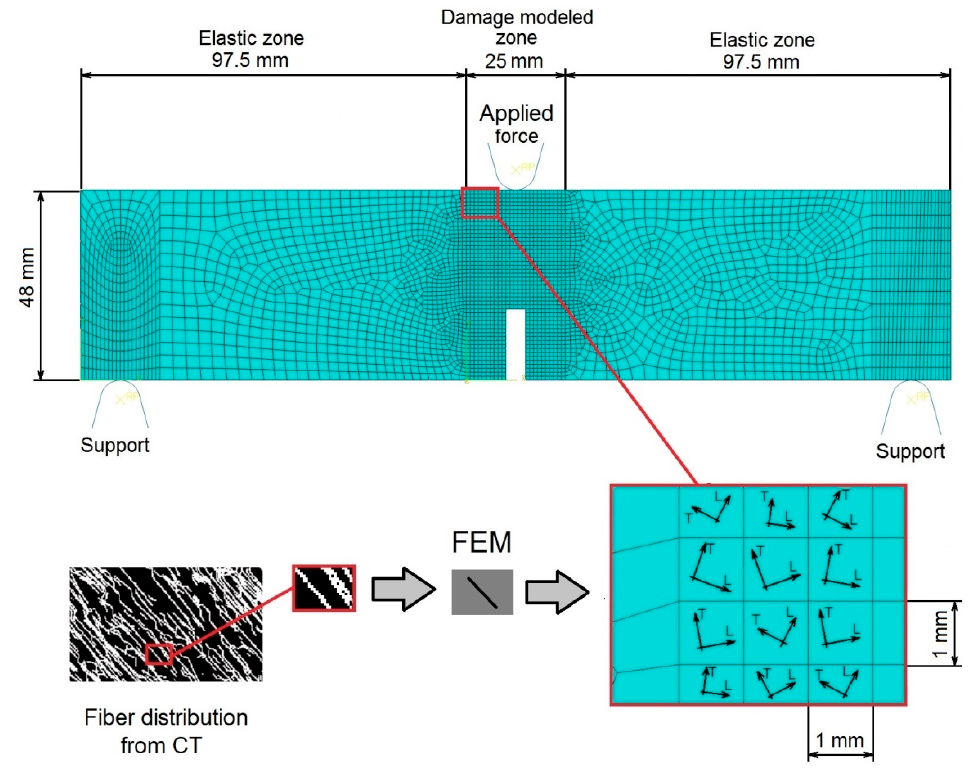
Figure 3. Adopted 2D finite element modeling (FEM) of three-point bending test with individual elements simulated by different constitutive models.